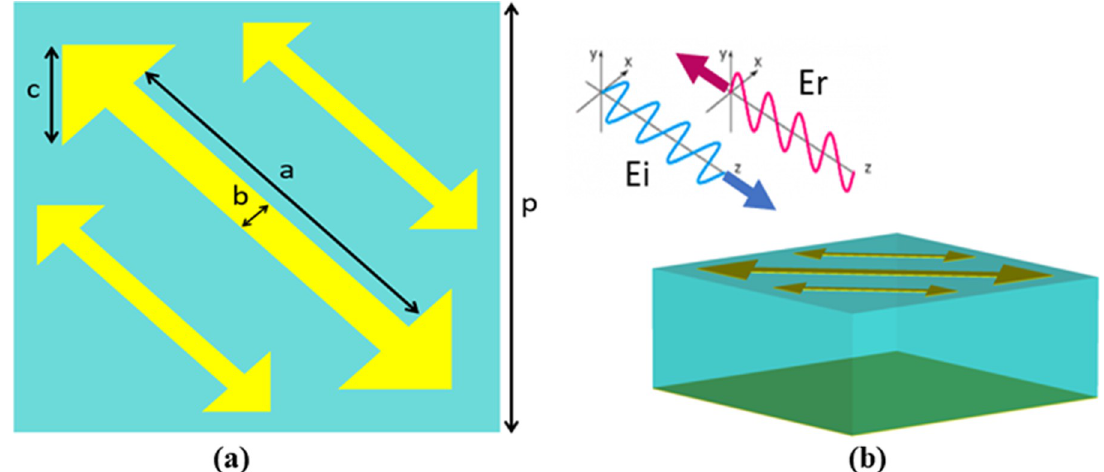
Fig 1. Unit cell schematic design (a) top view (b) 3D